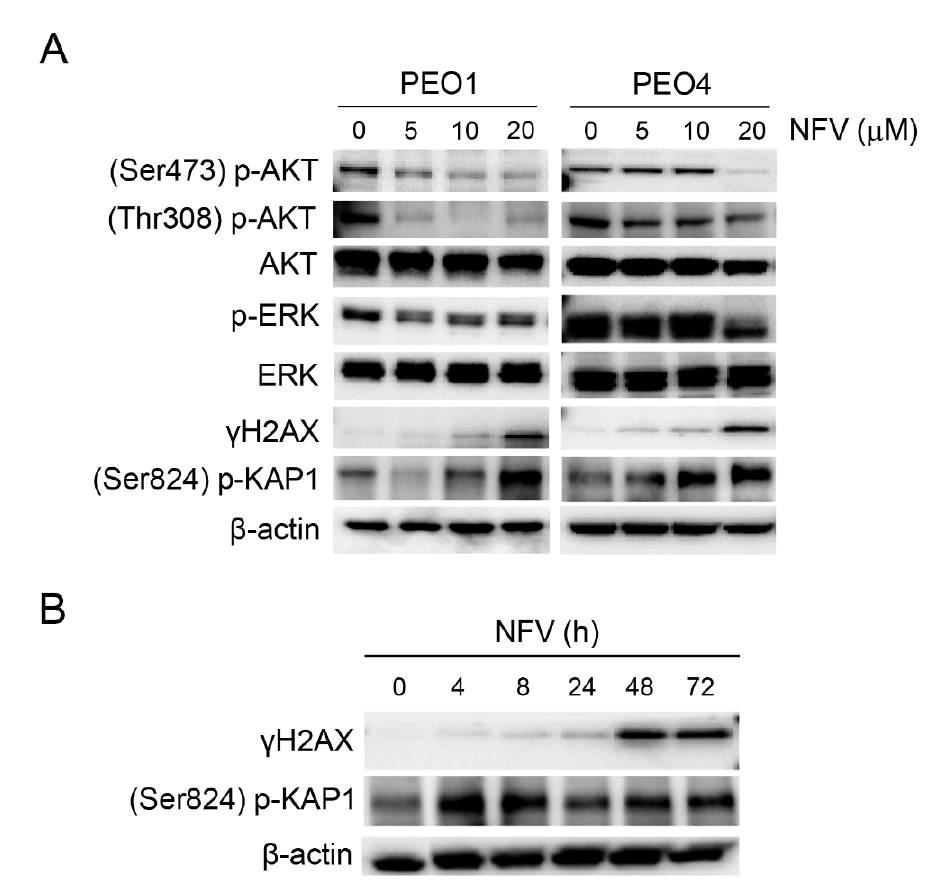
Figure 5. ( A ) PEO1 and PEO4 cells were incubated with the depicted concentrations of NFV for 72 h. Protein expression studied by Western blot demonstrates concentration-dependent decrease in the phosphorylation of AKT and ERK in both sibling cell lines, which was accompanied by a concurrent increase in DNA damage markers γ H2AX and (Ser824) p-KAP1. ( B ) Time course showing the induction of γ H2AX and (Ser824) p-KAP1 in PEO1 cells treated with 20 µ M NFV. All results presented are representative of at least two independent experiments that had a similar